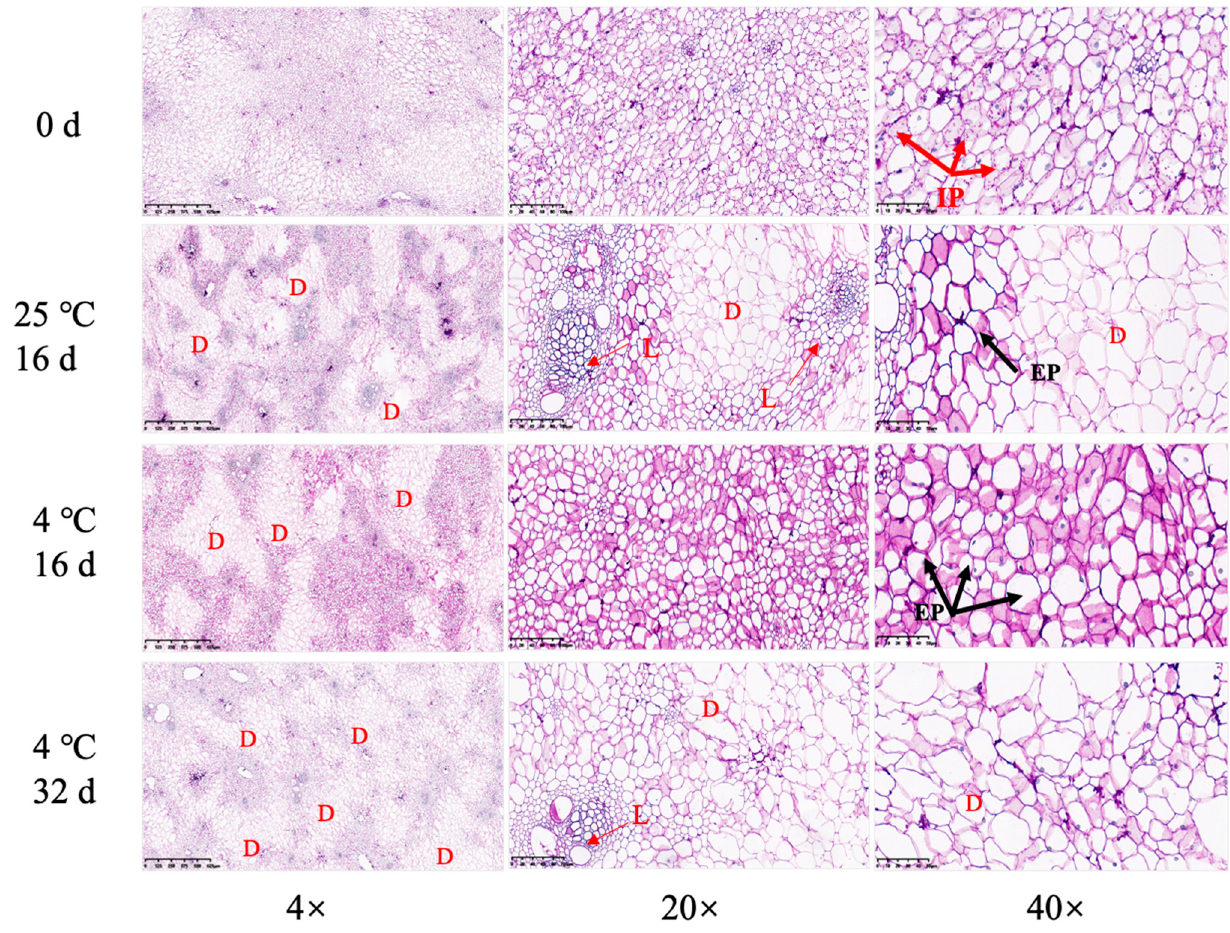
Figure 2. Polysaccharide staining of Z. latifolia cell walls using PAS during storage at different temperatures. D, polysaccharide degradation; L, lignification; IP, intracellular polysaccharide; EP, extracellular polysaccharide.